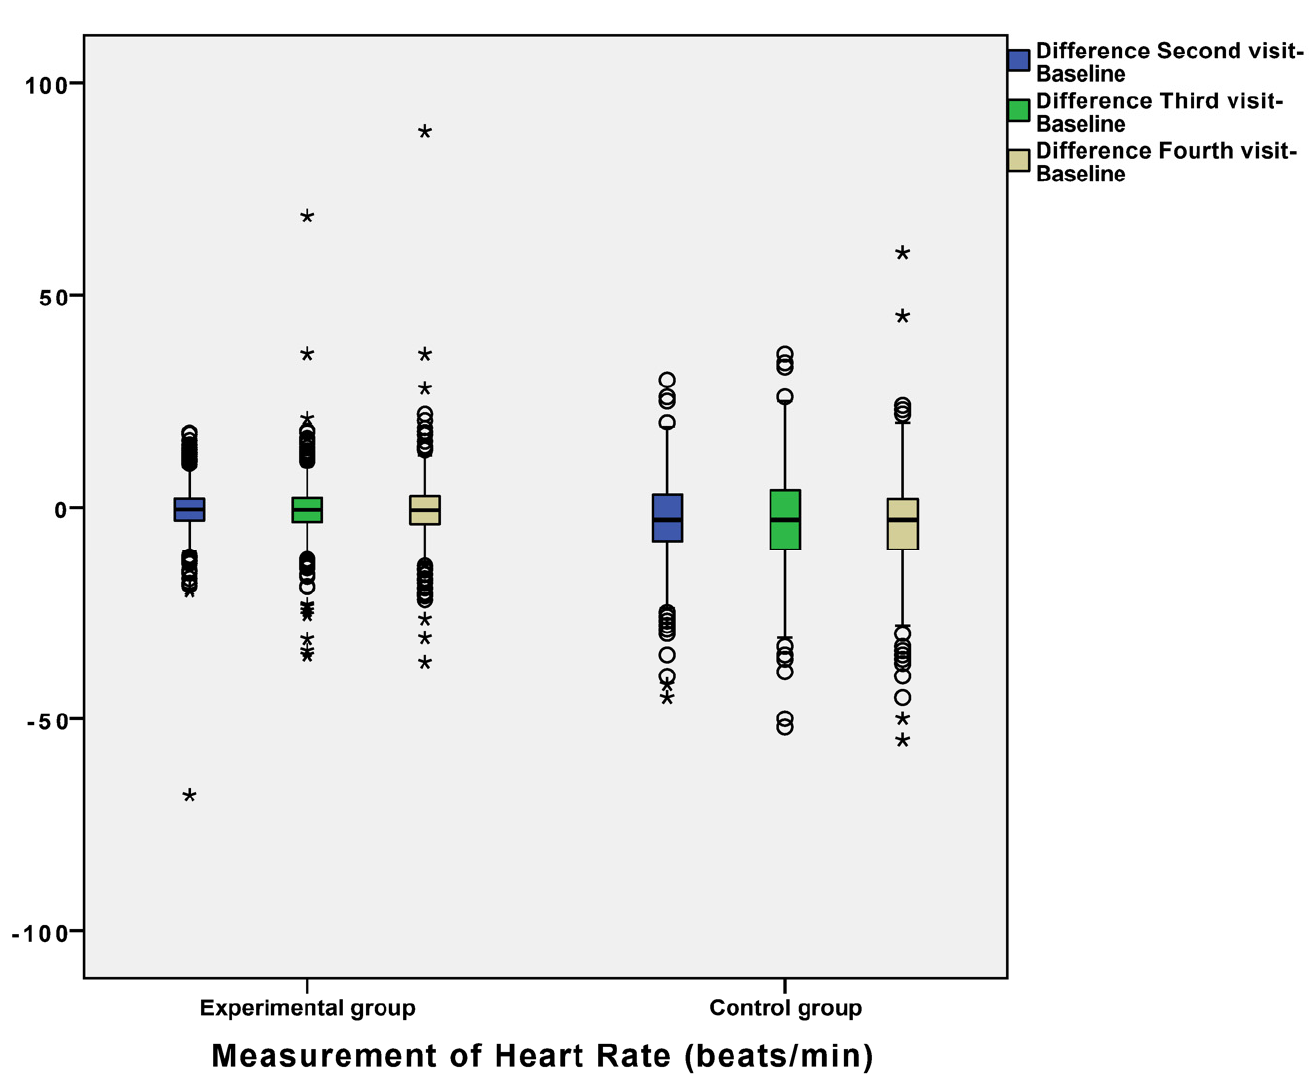
Figure 3. Box plot for differences between measurements of heart rate (HR) in experimental and control groups during the follow-up of patients. Statistical difference was confirmed by Wilcoxon test and marked with asterisk (* = p < 0.05). Table 5. Multivariate analysis of variance (MANOVA) in study population depending on presence of diabetes mellitus, dyslipidemia, smoking, hereditary factors, and time. An eta-squared ( η 2 ) value reflects the strength or magnitude related to a main or interaction effect (0.01 = small, 0.06 = medium, 0.13 = large).